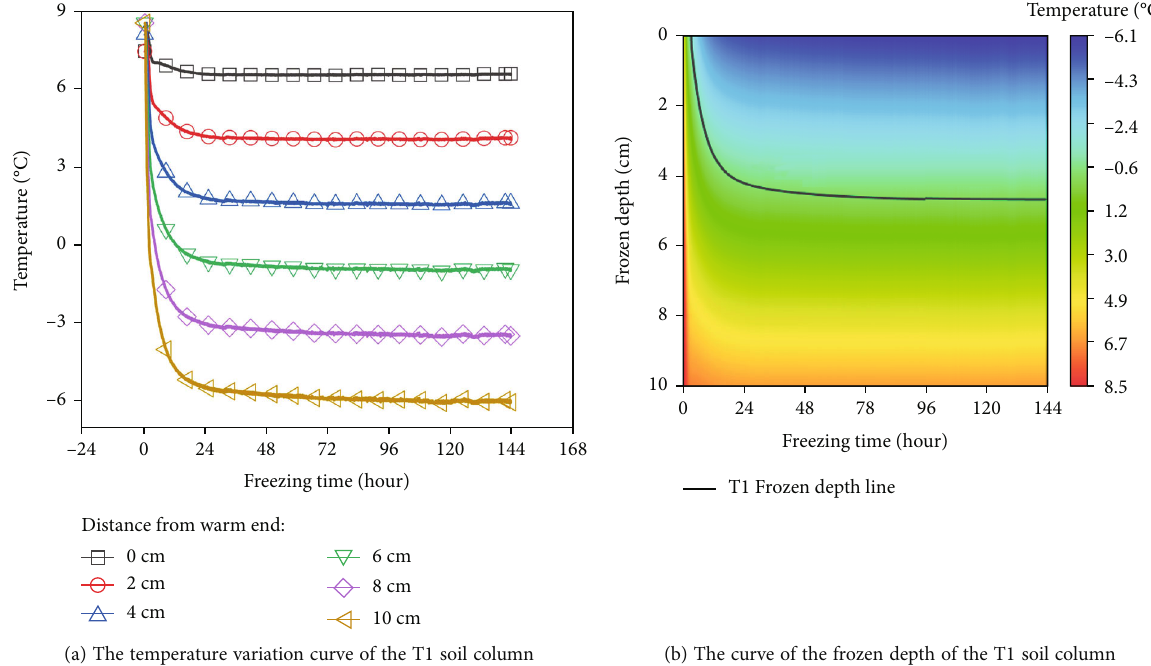
(b) The curve of the frozen depth of the T1 soil column Figure 6: The temperature fi eld variation law of the T1 soil column.